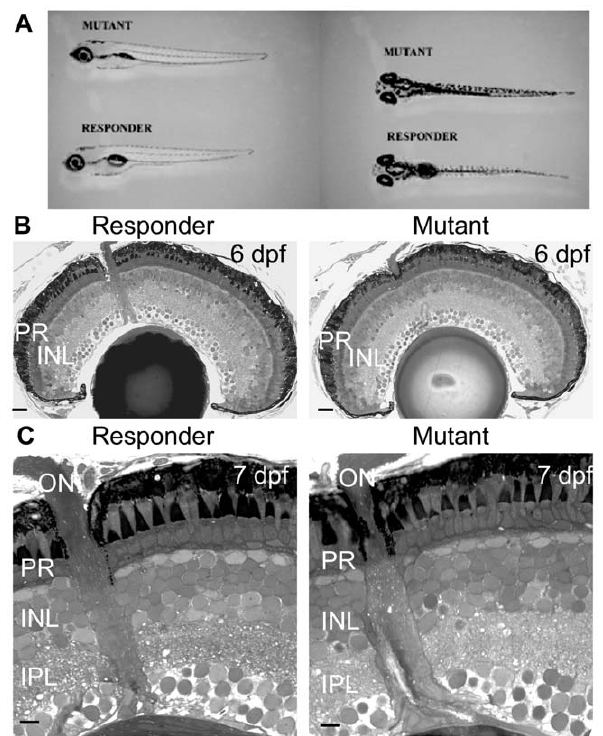
Figure 1. The morphology and retinal histology of the zvm7 w65 mutant appears normal. A) Mutant fish at 5 dpf do not develop a swim bladder but appear otherwise normal. B and C) The histology of the eye appears normal in the zvm7 w65 mutant. B) 6 dpf retinas. Scale bars are 20 m m C) magnification of 7 dpf retinas. Scale bars are 5 m m. PR, photoreceptors; INL, Inner Nuclear Layer; IPL, inner plexiform